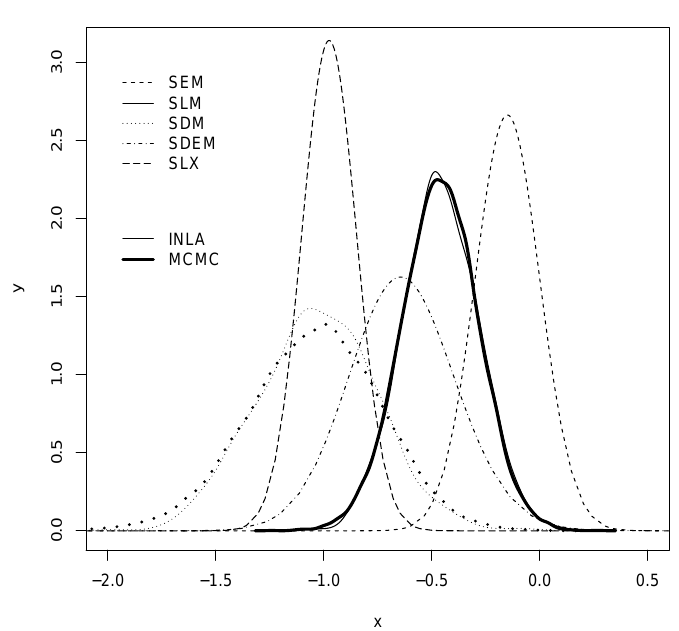
Figure 4. Total impacts for NOX-squared obtained with different models, Boston housing